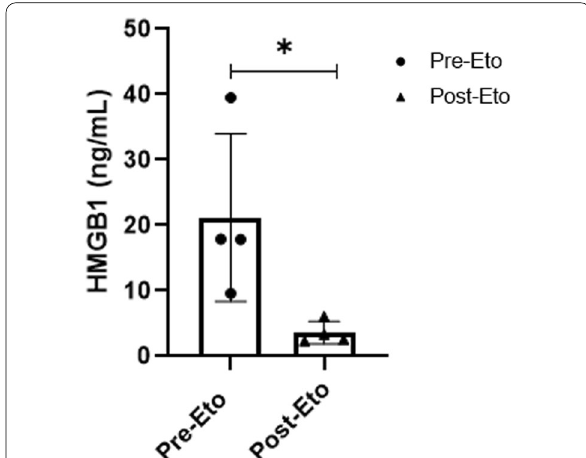
Fig. 6 Plasma HMGB1 levels in the four MAS patients before and after etoposide therapy. Plasma HMGB1 measured by ELISA was markedly increased in all patients during severe MAS before etoposide (Eto) treatment was added to ongoing therapy. Plasma HMGB1 concentration immediately before first dose of etoposide was compared to last available sample. HMGB1 levels were significantly reduced (* p < 0.05) post etoposide